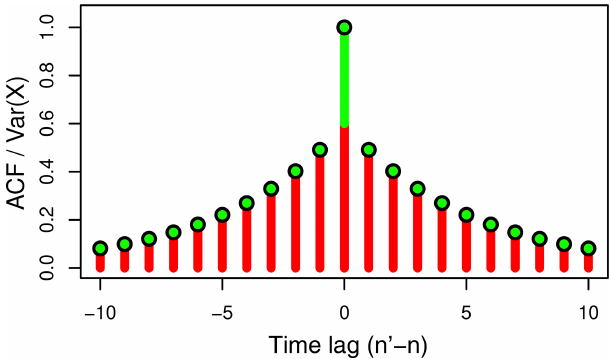
Figure 3. Schematic illustration of the auto-covariance function of the discrete process X ( j ) n (black circles), as given by Eq. (32), nor- malized by the variance of X ( t ) and the auto-covariance contribu- tion from U n (red lines), as given by Eq. (46), and from V ( j ) n (green lines), as given by Eq. (47), with green dots indicating zero contri-